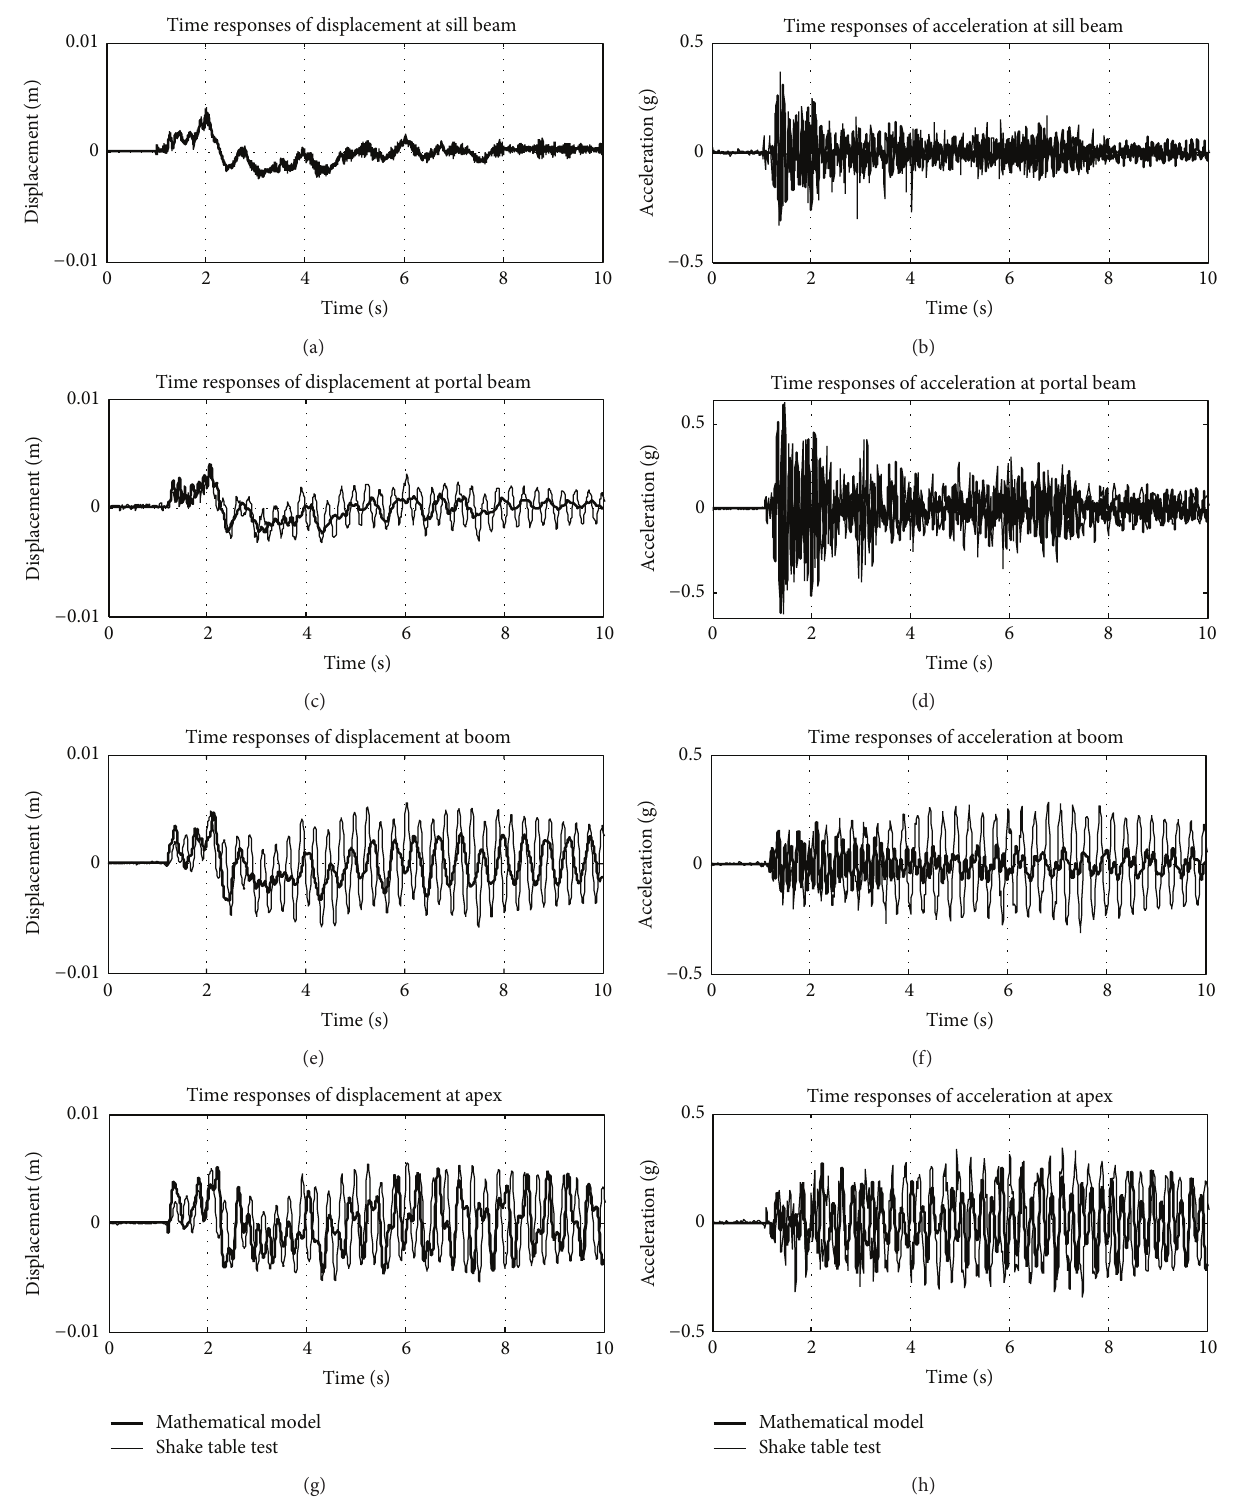
Figure 8: Comparison of the mathematical model and shake table test